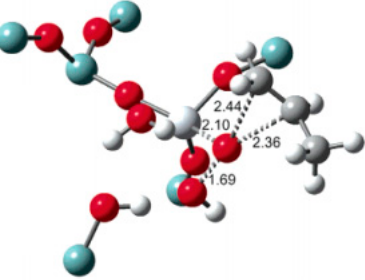
Figure 3. Transition state for the reaction of the hydroperoxy intermediate on a defect Ti site with propylene [32]. (Ti = large white, O = red, Si = blue, H = small white spheres). Copyright © 2004 American Chemical Society.